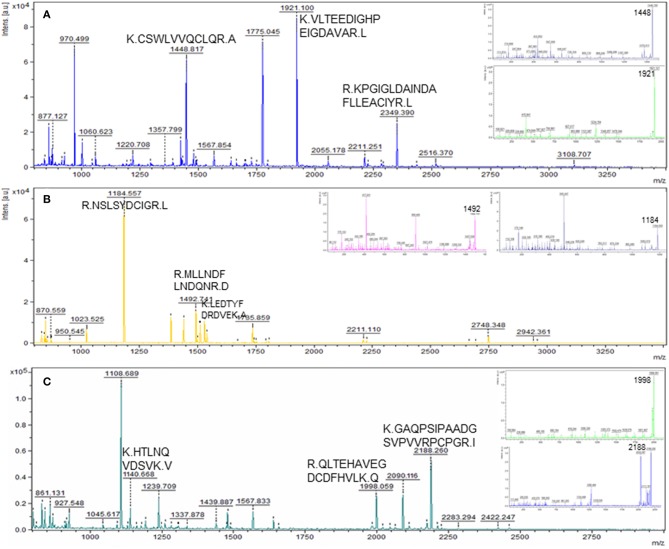
Representative MS and MS/MS (insets) spectra of some of the novel differentially abundant proteins in the CL as compared to POF. Matched peptides with a significant ion score of >30 are shown. (A) Peptides KCSWLVVQCLQRA, KVLTEEDIGHPEIGDAVARL, and RKPGIGLDAINDAFLLEACIYRL matched to protein FDPS; (B) peptides RNSLSYDCIGRL, RMLLNDFLNDQ NRD, and KLEDTYFDRDVEKA matched to protein HMGCS1; (C) peptides KHTLNQVDSV KV, RQLTEHAVEGDCDFHVLKQ, and KGAQPSIPAADGSVPVVRPCPGRI matched to protein AHSG.